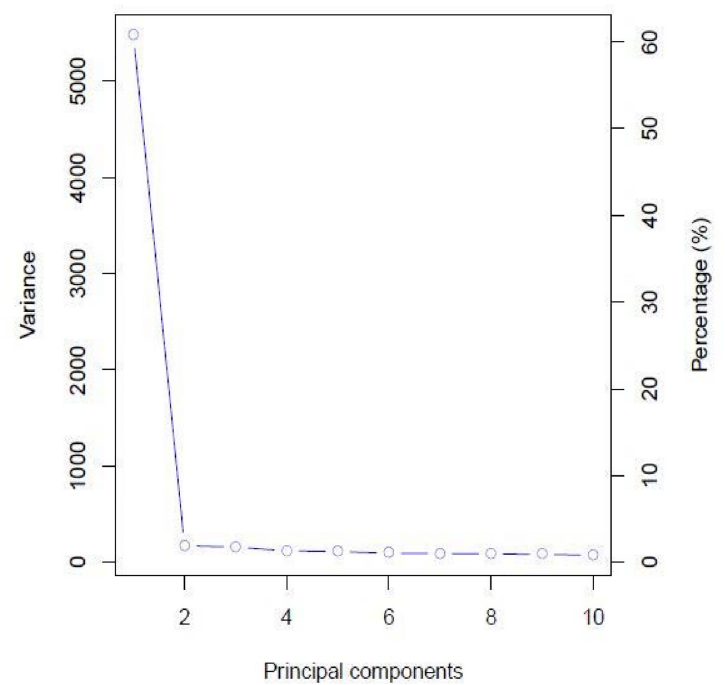
Fig 2. Scree plot showing principal components when assessing 99 common bean genotypes using SNP markers.